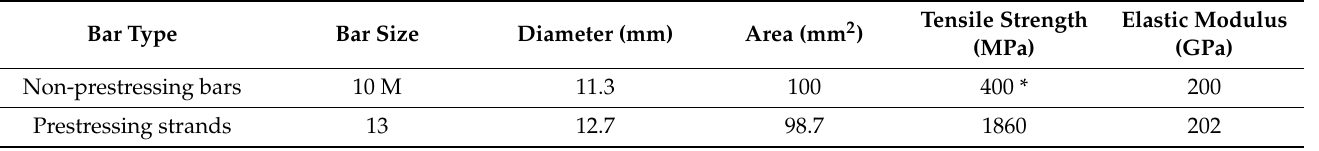
Table 1. Mechanical properties of used reinforcement.